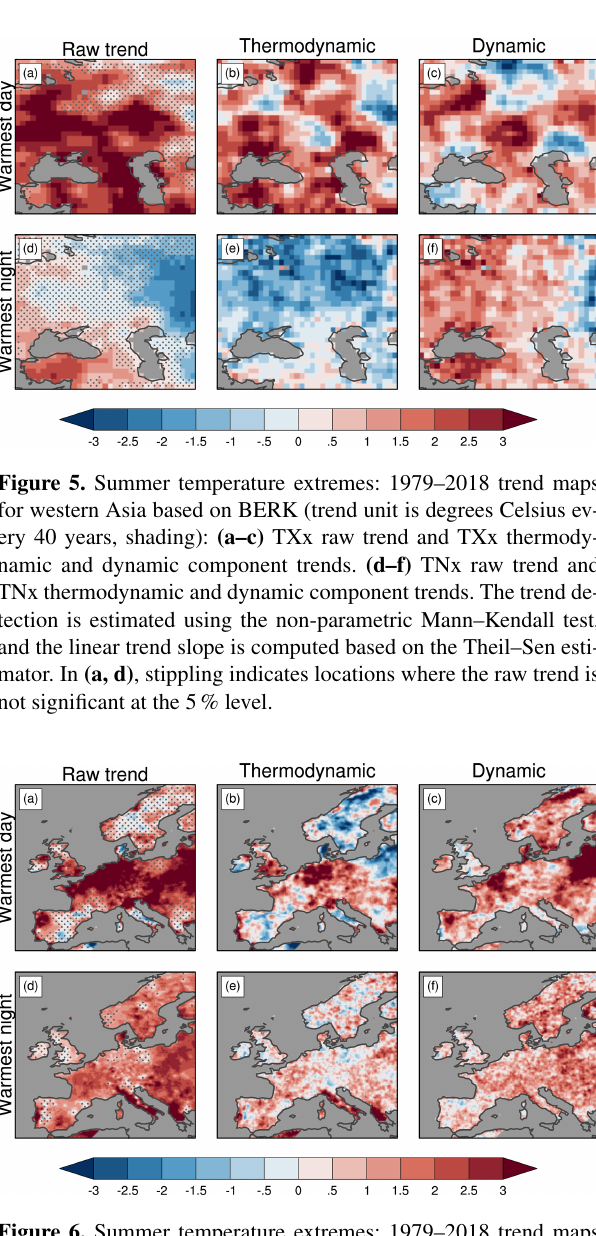
Figure 6. Summer temperature extremes: 1979–2018 trend maps for western Europe based on EOBS (trend unit is degrees Celsius every 40 years, shading): (a–c) TXx raw trend and TXx thermo- dynamic and dynamic component trends. (d–f) TNx raw trend and TNx thermodynamic and dynamic component trends. The trend de- tection is estimated using the non-parametric Mann–Kendall test, and the linear trend slope is computed based on the Theil–Sen esti- mator. In (a, d) , stippling indicates locations where the trend is not significant at the 5%